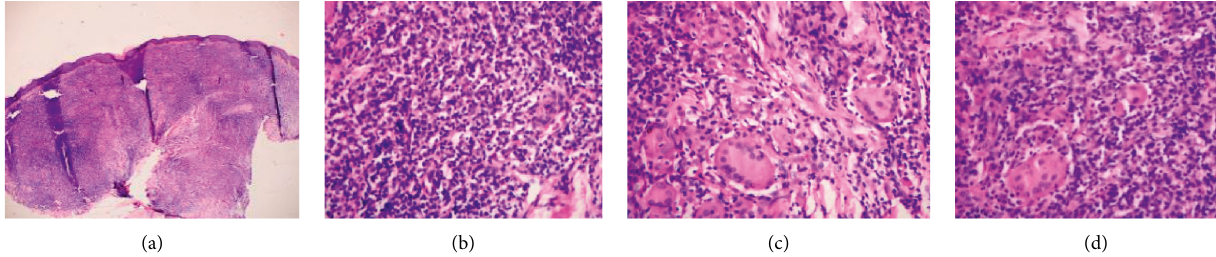
Figure 1: (a) H and E stained wedge shaped incisional biopsy, bisected from the skin on her trunk. (b) Diffused granulomatous with multiple histiocytes with a background of lymphocytes periadnexal inflammatory cell infiltrate. (c) and (d) Multinucleated giant cell and Touton giant cells. All were suggestive of lupus vulgaris. No acid-fast bacilli were seen.